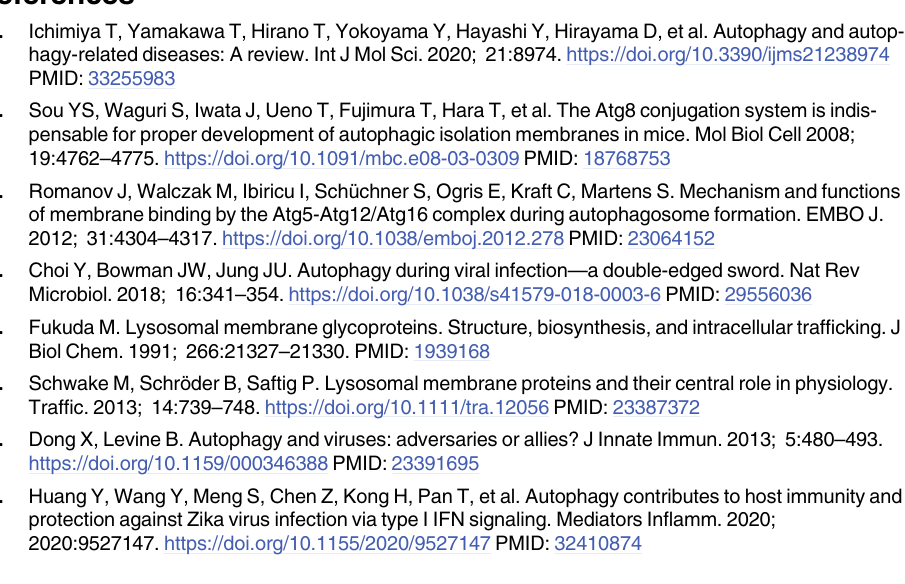
S4 Fig. Yeast two hybrid assay for detection of the interactions between Pns11 and other ATG proteins of R . dorsalis . Interactions between Pns11 and ATG3, ATG7, ATG8 or ATG10 were detected by yeast two-hybrid assay. Transformants were plated on either DDO or QDO+X- α -Gal culture medium, and the pairs are labeled as follows: Pns11/ATG3, pGBKT7-Pns11/pGADT7-ATG3; Pns11/ATG7, pGBKT7-Pns11/pGADT7-ATG7; Pns11/ ATG8, pGBKT7-Pns11/pGADT7-ATG8; Pns11/ATG10, pGBKT7-Pns11/pGADT7-ATG10;